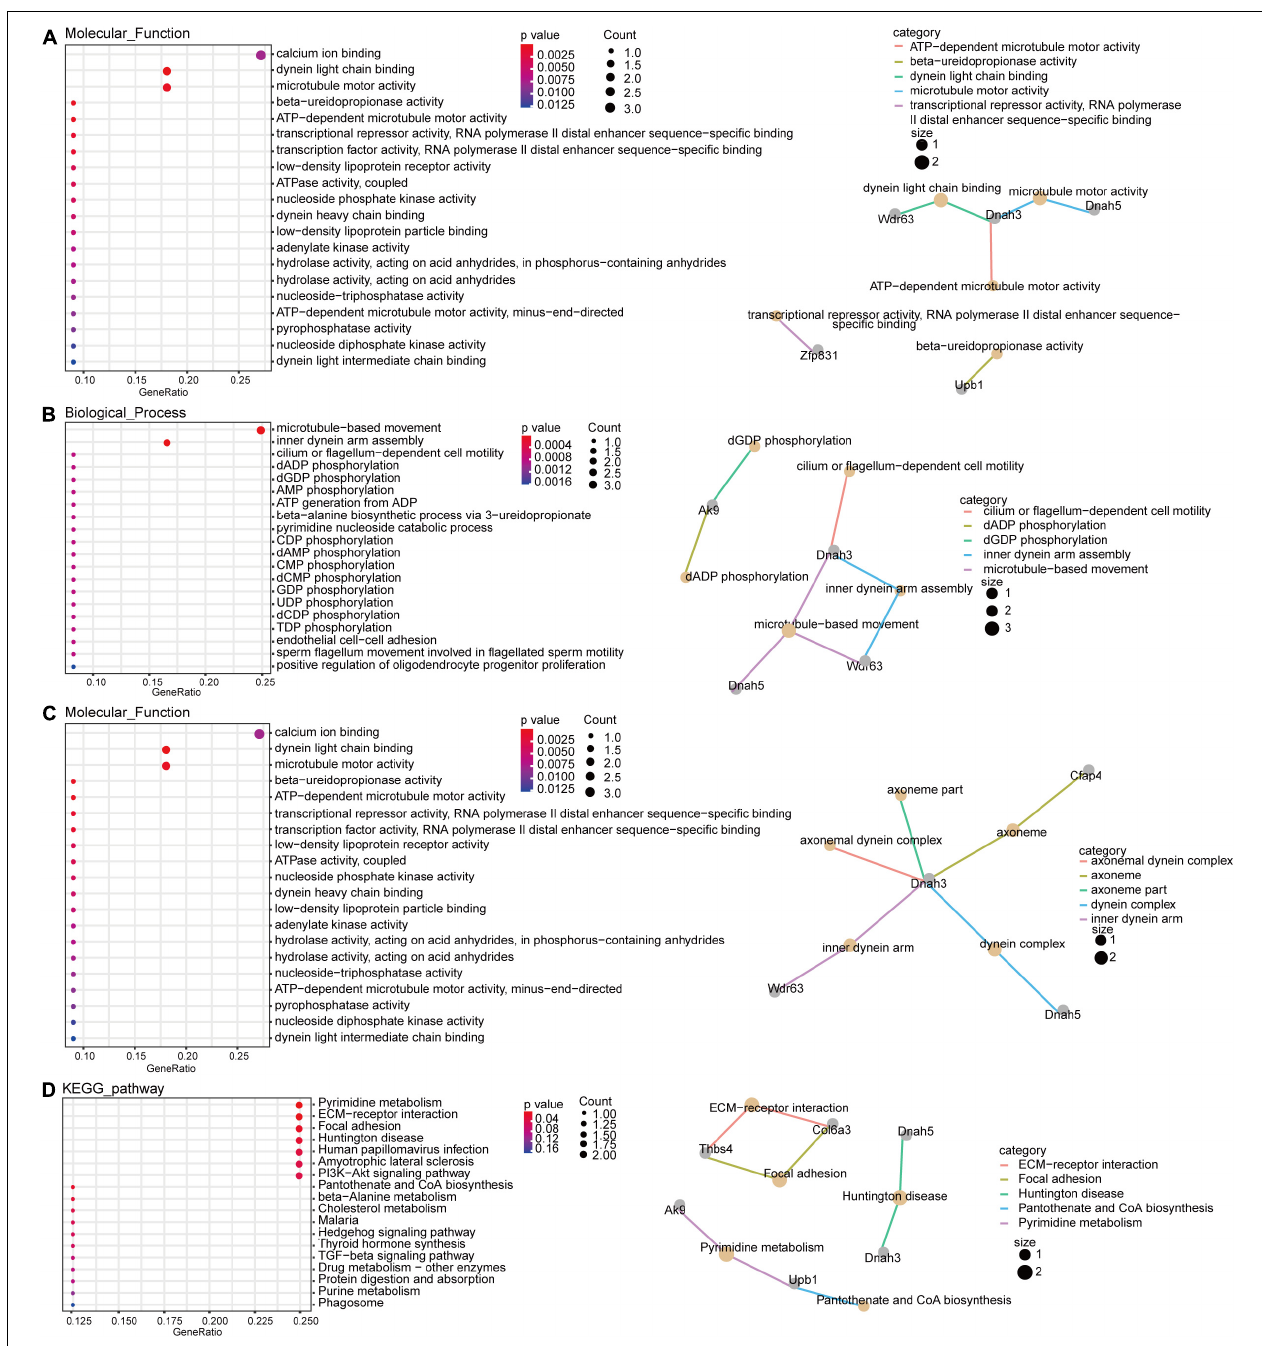
FIGURE 5 | Gene Ontology (GO) and KEGG pathway function enrichment analysis for DEmRNAs. The significant molecular functions (A) , biological processes (B) and cellular components (C) of DEmRNAs in the ceRNA network were presented using GO analyses. Pathway analyses results of DEmRNAs in the ceRNA network with fold changes > 1.5 (D)